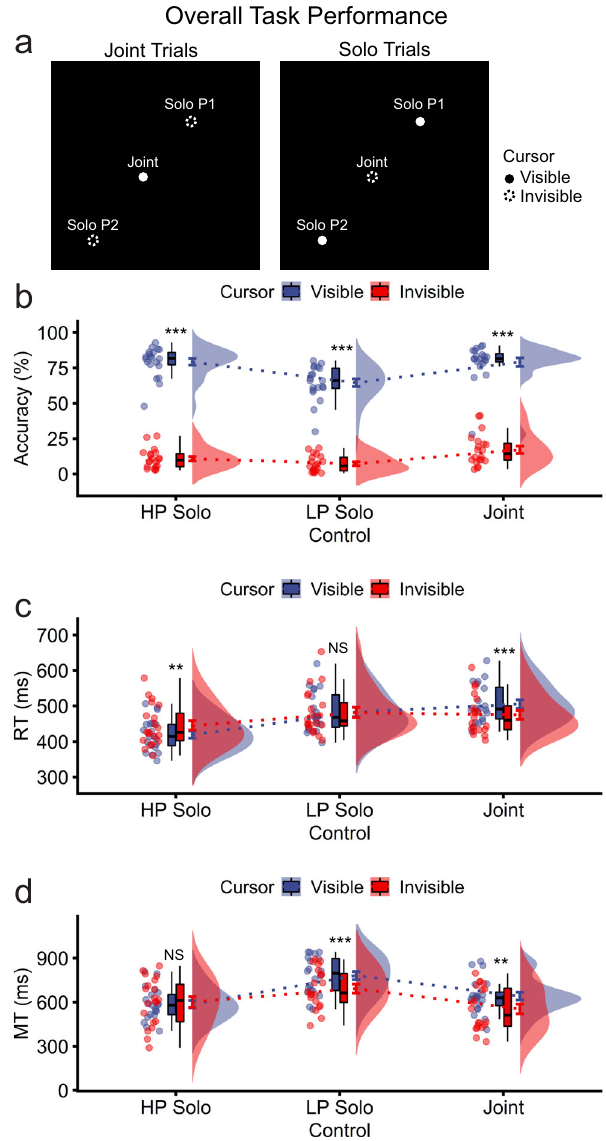
precision for joint control compared with LP solo control . To further understand how joint control affects action execution, cursor trajectories were plotted by cursor visibility and cursor control. As depicted in Fig. 3a, visible trajectories appeared straighter for joint control relative to LP solo control. Trajectory curvature (°) was analysed via a two-way ANOVA with the factors of cursor visibility (visible, invisible) and cursor control (LP solo, HP solo, joint). All ANOVA-level effects were signi fi cant, and importantly, consistent with real-time coordination. The cursor visibility × cursor control interaction was signi fi cant ( F 2,38 = 61.20, p = 1.31e – 12, η p 2 = 0.763), as was the main effect of cursor visi- bility ( F 1,19 = 43.99, p = 2.41e-06, η p 2 = 0.698). Follow-up tests for visible cursors showed a signi fi cant simple effect of cursor visibi- lity ( F 2,38 = 71.39, p = 1.35e-13, η p 2 = 0.79), with trajectory cur- vature signi fi cantly smaller for joint control ( M = 0.28, SD = 0.11) compared with LP solo control ( M = 0.47, SD = 0.09; t 19 = = 8.28, p = 9.99e-08). Curvature was statistically equivalent for joint